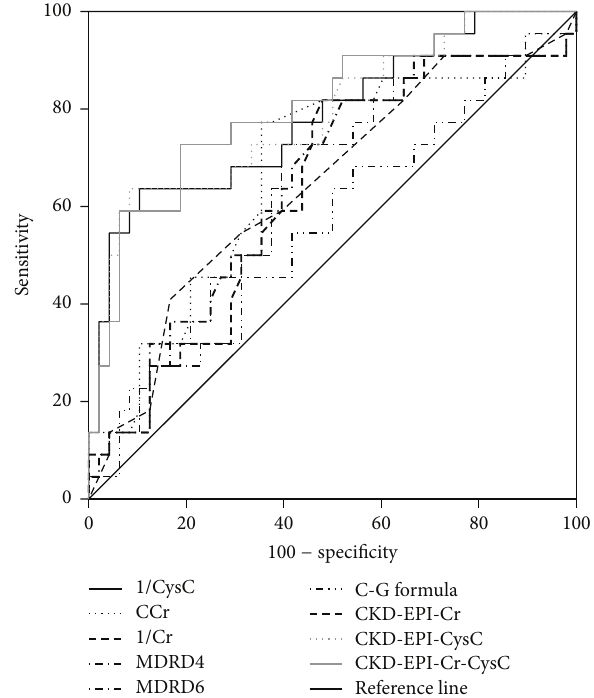
Figure 2: ROC curves of 1/creatinine, creatinine clearance, 1/cys- tatin C, MDRD equations with 4 and 6 variables, Cockcroft-Gault formula, CKD-EPI-Cr, CKD-EPI-CysC, and CKD-EPI-Cr-CysC for detecting early renal impairment.